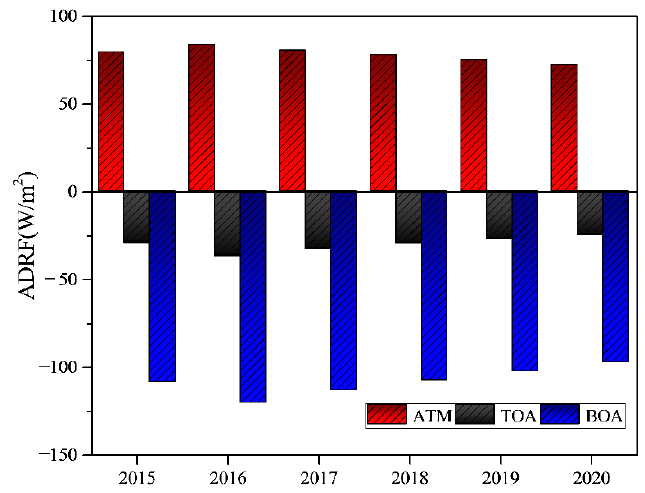
Figure 3. Annual average of ADRF from 2015 to 2020.